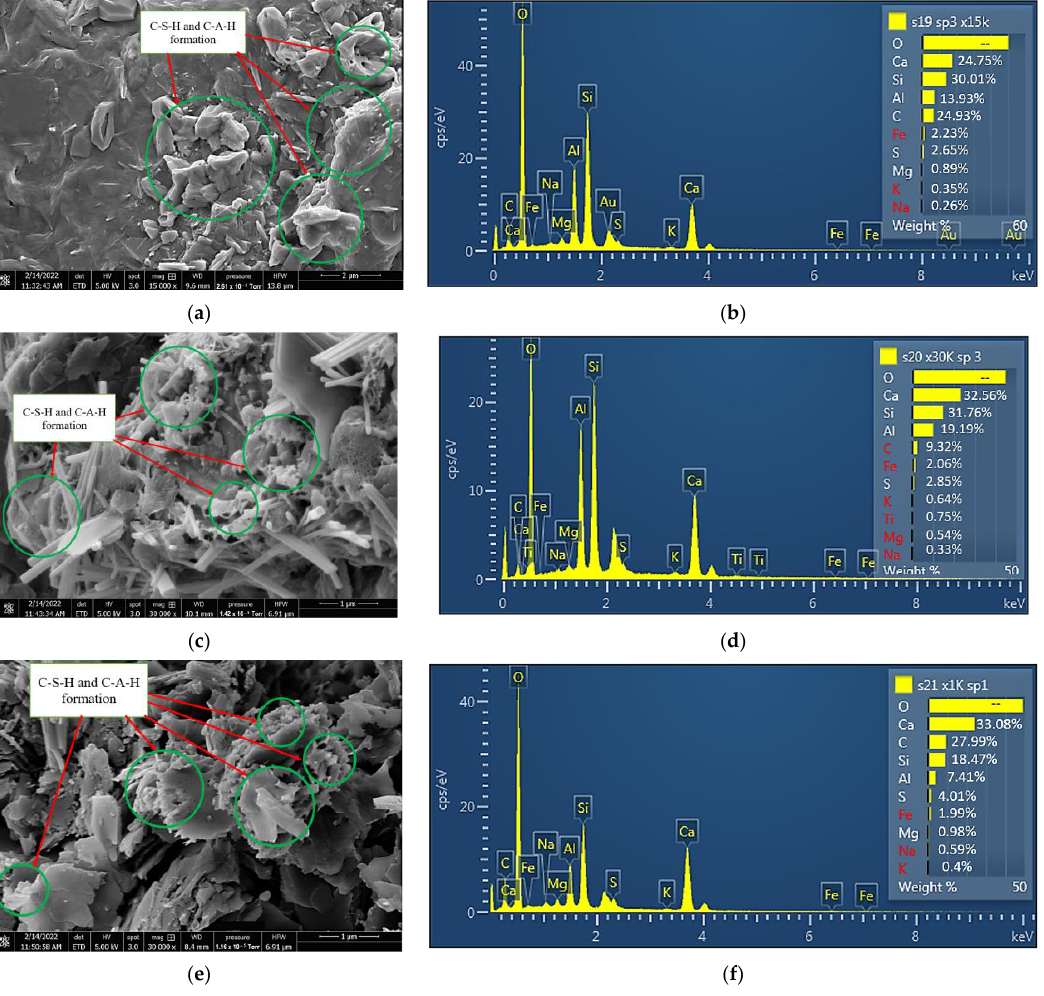
Figure 13. ( a ) SEM image results for ASS 1 after seven days of curing; ( b ) EDX results for ASS 1 after seven days of curing; ( c ) SEM image results for ASS 2 after seven days of curing; ( d ) EDX results for ASS 2 after seven days of curing; ( e ) SEM image results for ASS 3 after seven days of curing; ( f ) EDX results for ASS 3 after seven days of